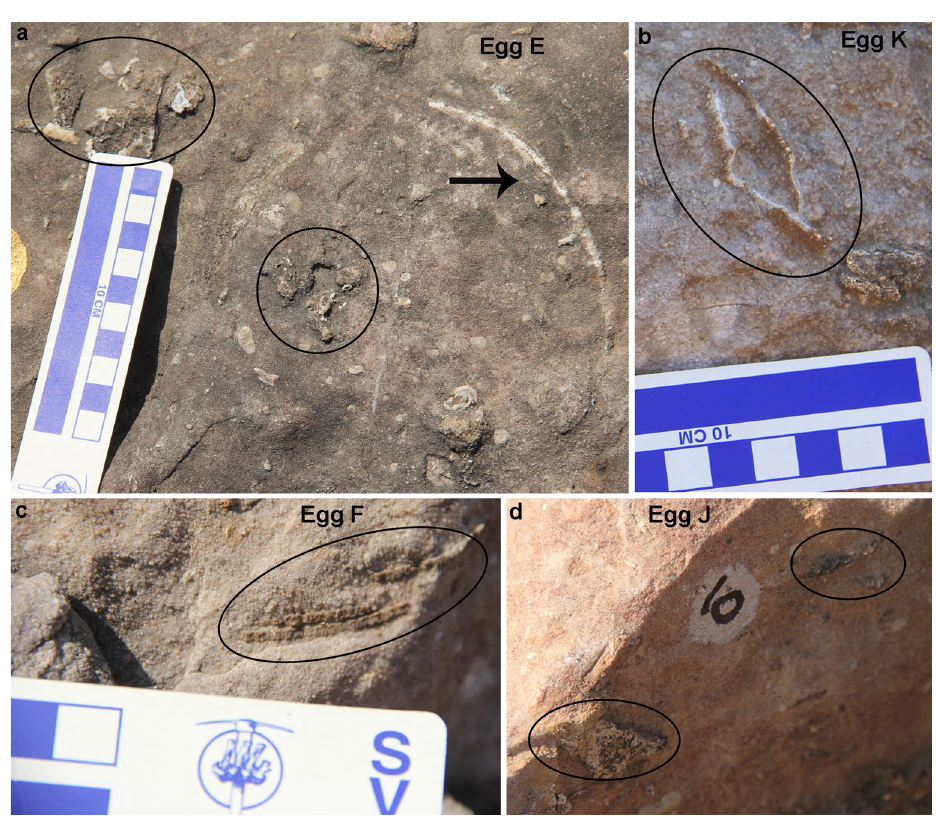
Figure 8. Field photographs of eggs from nest number P7 showing randomly distributed eggshell